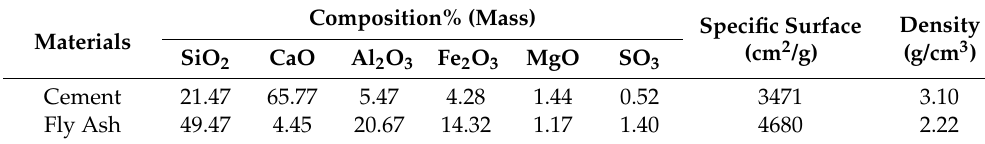
Table 2. Chemical compositions and physical properties of the cementitious materials.